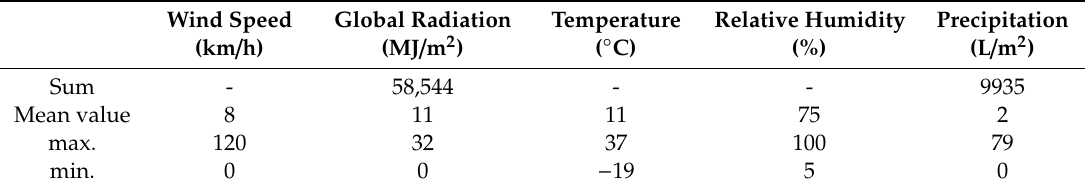
Table 1. Overview of the observed climate data of the weathering period: Wind speed, global radiation, temperature, relative humidity, and precipitation.